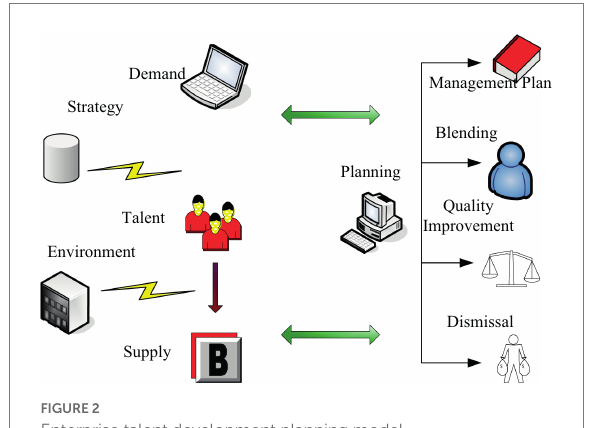
FIGURE 2 Enterprise talent development planning